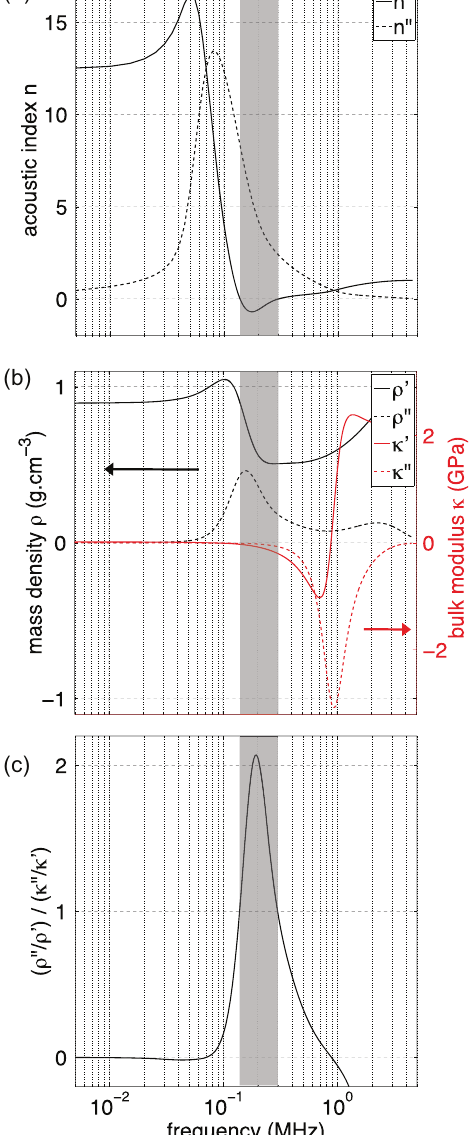
Figure 2. Real and imaginary parts of the dynamic properties for an acoustic metafluid with 20% of soft porous silicone micro-beads versus the frequency. (a) The acoustic index n (= n 0 + i n 00 ), (b) the constitutive parameters: bulk modulus j (= j 0 + i j 00 ) and mass density q (= q 0 + i q 00 ) and (c) the ratio ( q 00 / q 0 )/( j 00 / j 0 ). The shaded area [0.14–0.3 MHz] corresponds to the negative-index frequency band ( n 0 <